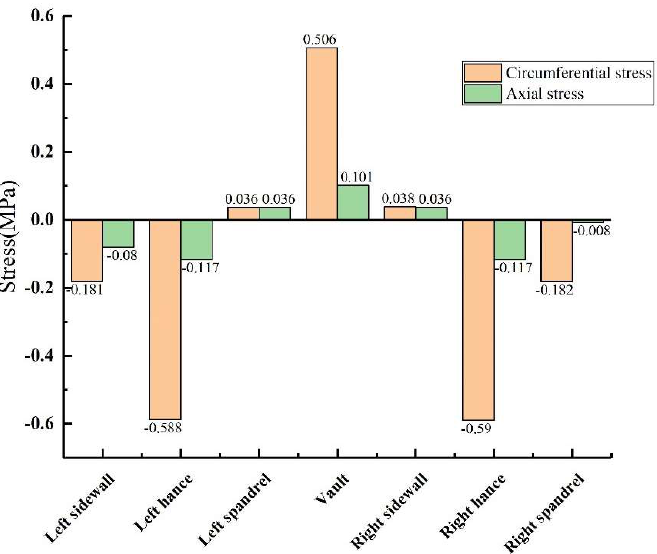
Figure 9. Lining without